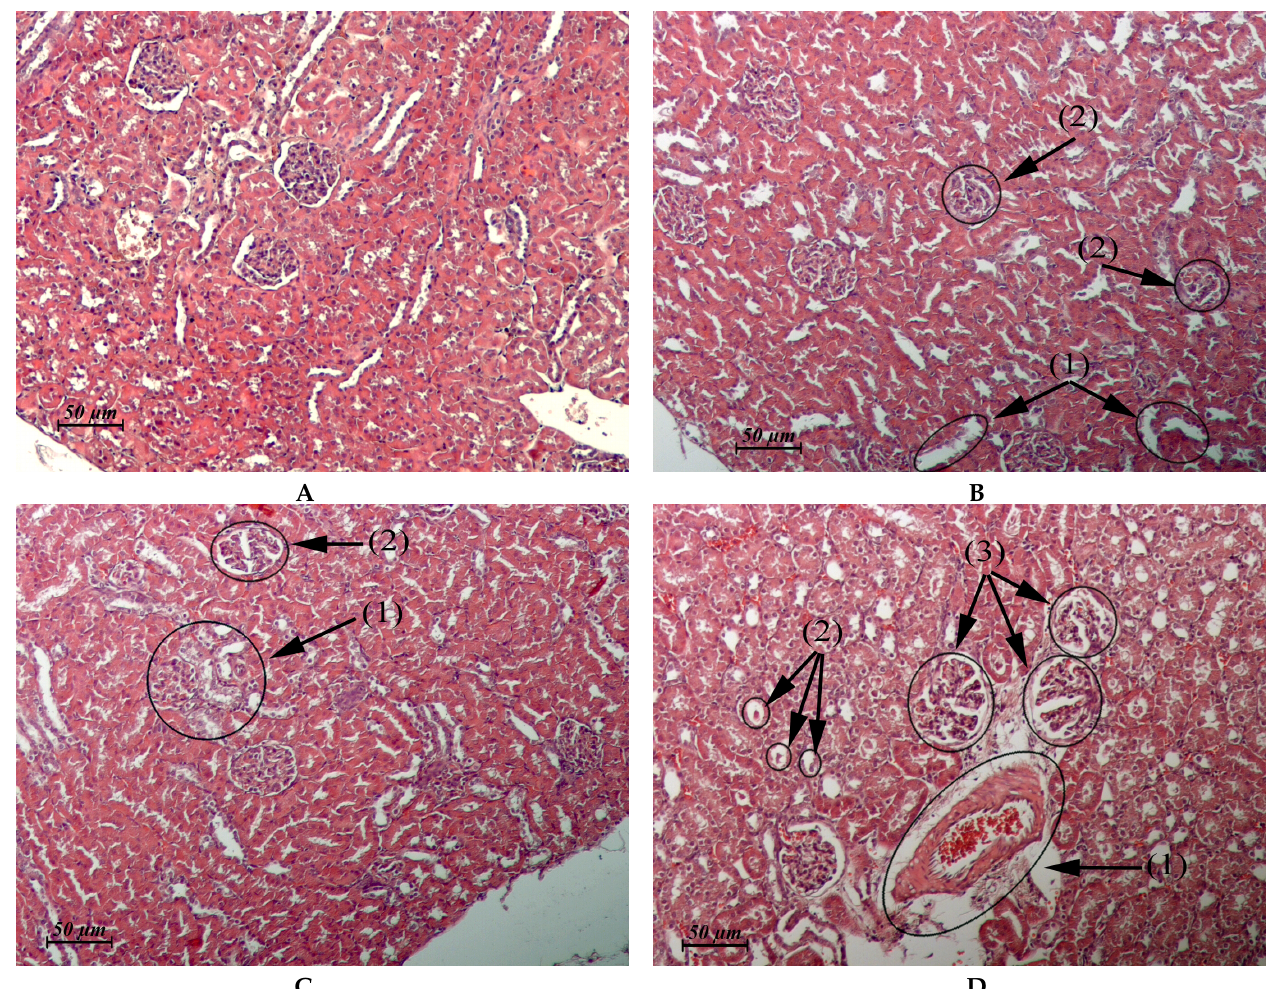
Figure 3. ( A – D ) Rat kidney. ( A ) Untreated control. ( B ) Cortical zone. Flavancin, 15 × 6 mg/kg/day, 1 day post-treatment. Vacuolar dystrophy of epithelium of some convoluted tubules (1). Thickening of the capsule and focal atrophy of the capillary network in glomerulus (2). ( C ) Cortical zone. Fuvancin, 15 × 10 mg/kg/day, 1 day post-treatment. Small focus of granular and vacuolar dystrophy of epithelium of convoluted tubules (1), clawed glomerulus (2). ( D ) Juxtamedullary zone. Flavancin, 15 × 10 mg/kg/day, 1 day post-treatment. Perivascular edema (1), destruction in the epithelial layer of some convoluted tubules (2), and clawed glomeruli with a sharply expanded lumen of the capsule (3) × 20.